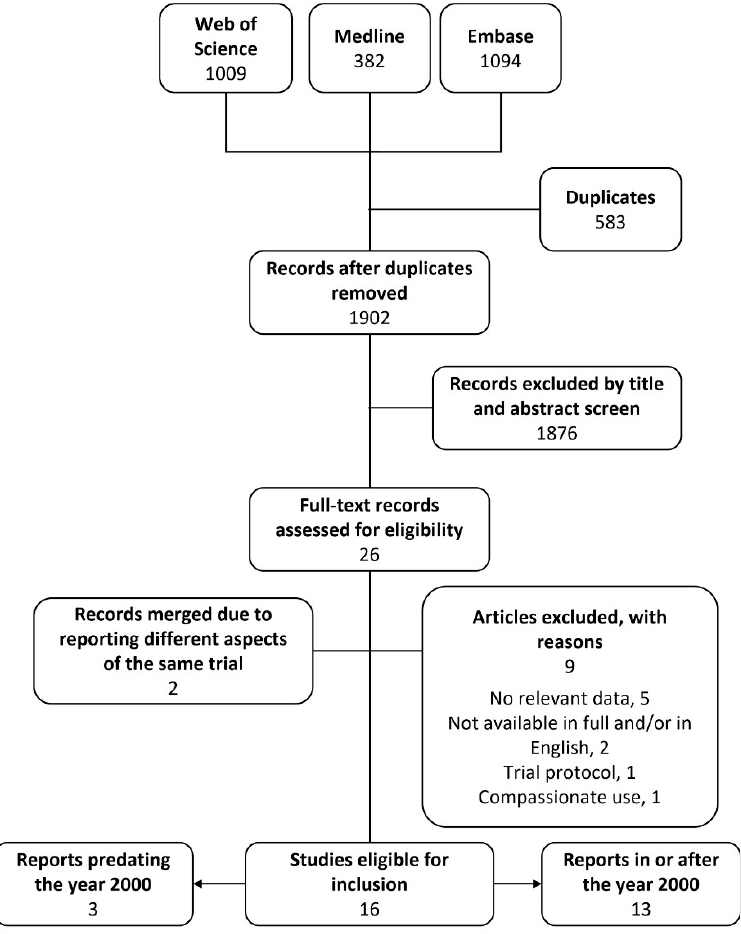
Figure 1. Flow diagram of study selection.